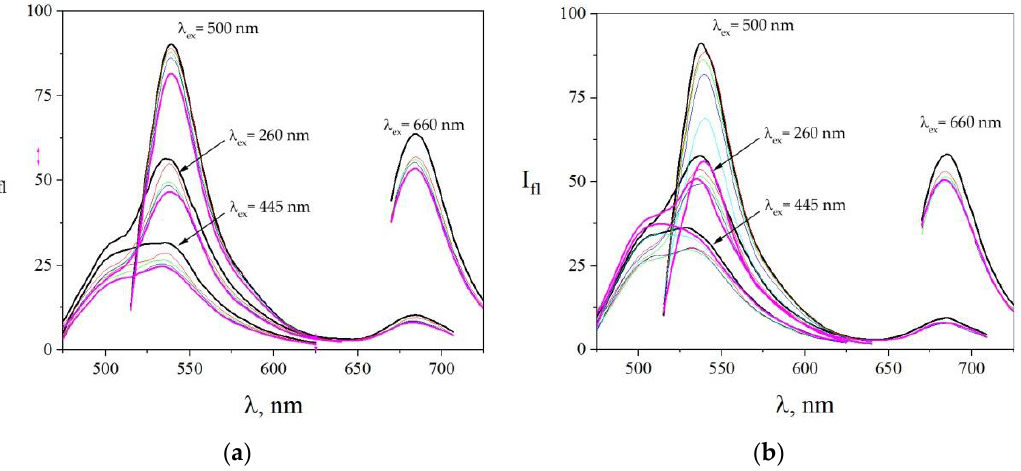
Figure 4. The spectra of the fluorescent probe array after adding heavy metal ions to a solution, subject of excitation at various wavelengths, 260 – 660 nm. ( a ) Case of [Cu 2+ ], wherein the concentrations of the salt were C Cu(NO3)2 = 0 M (black line), C Cu(NO3)2 = 2.41 × 10 −6 M (red line), C Cu(NO3)2 = 4.67 × 10 −6 M (green line), C Cu(NO3)2 = 6.8 × 10 −6 M (blue line), and C Cu(NO3)2 = 1.07 × 10 −5 M (purple line). ( b ) Case of [Pb 2+ ], wherein the concentrations of the salt are C Pb(NO3)2 = 0 M (black line), C Pb(NO3)2 = 2.8 × 10 −5 M (red line), C Pb(NO3)2 = 7.9 × 10 −5 M (green line), C Pb(NO3)2 = 1.24 × 10 −4 M (blue line), C Pb(NO3)2 = 3.26 × 10 −4 M (aquamarine line), and C Pb(NO3)2 = 5.87 × 10 −4 M (purple one). The excitation wavelengths are shown in the figure.